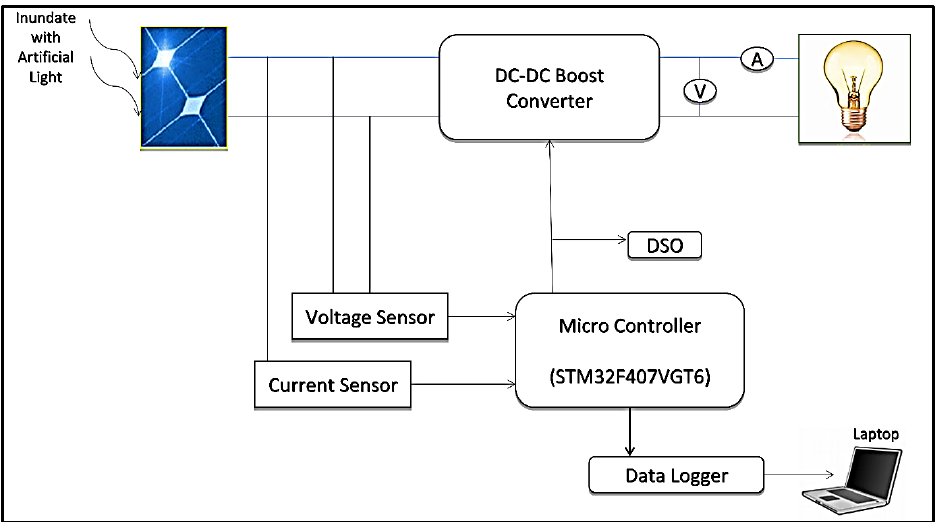
Figure 15. Block diagram of experimental study.